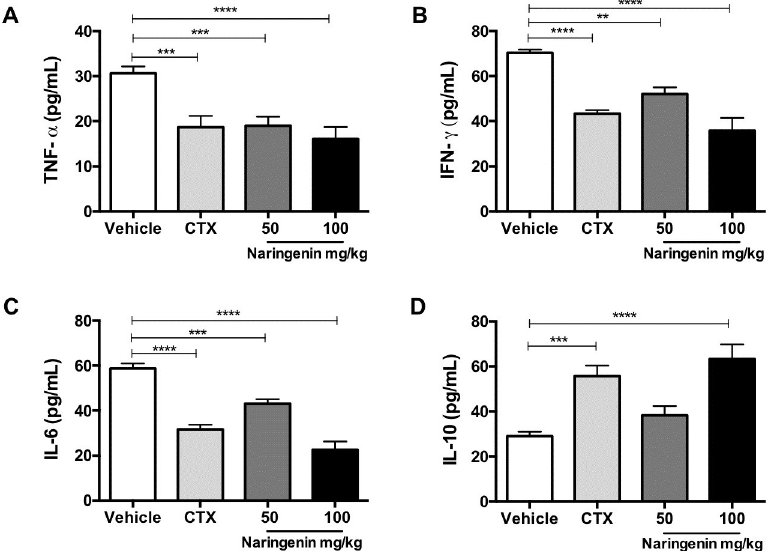
Fig 3. Naringenin reduced the serum concentration of proinflammatory cytokines and increased the concentration of IL-10. Previous to sacrifice, serum was obtained from each mouse by blood sampling of the submandibular vein. The cytokines concentration from each serum sample was measured by ELISA assay. Naringenin reduced the serum concentration of proinflammatory cytokines as (A) TNF- α , (B) IFN- γ , (C) IL-6. Conversely, Naringenin at a dose of 100 mg/kg significantly increased the serum concentration of (D) IL-10, an anti-inflammatory cytokine. Statistical analysis was carried out by one-way ANOVA followed by Tukey’s test and data presented as mean ± SD, n � 5. �� p � 0.01, ��� p � 0.001, ���� p � 0.0001 compared versus vehicle.